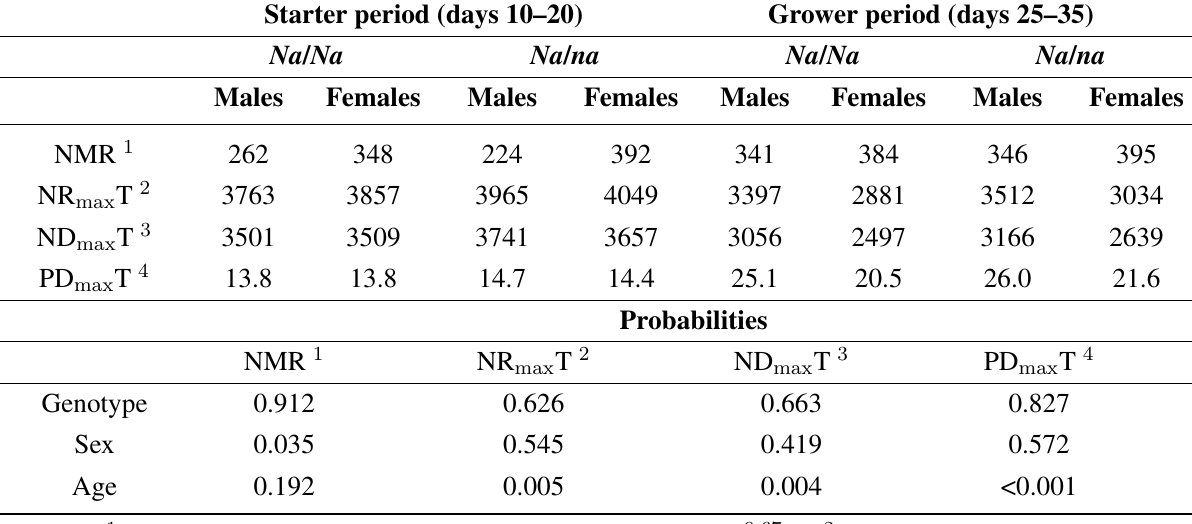
Table 6. Model parameters for fast growing naked neck chicken related to age period, genotype and